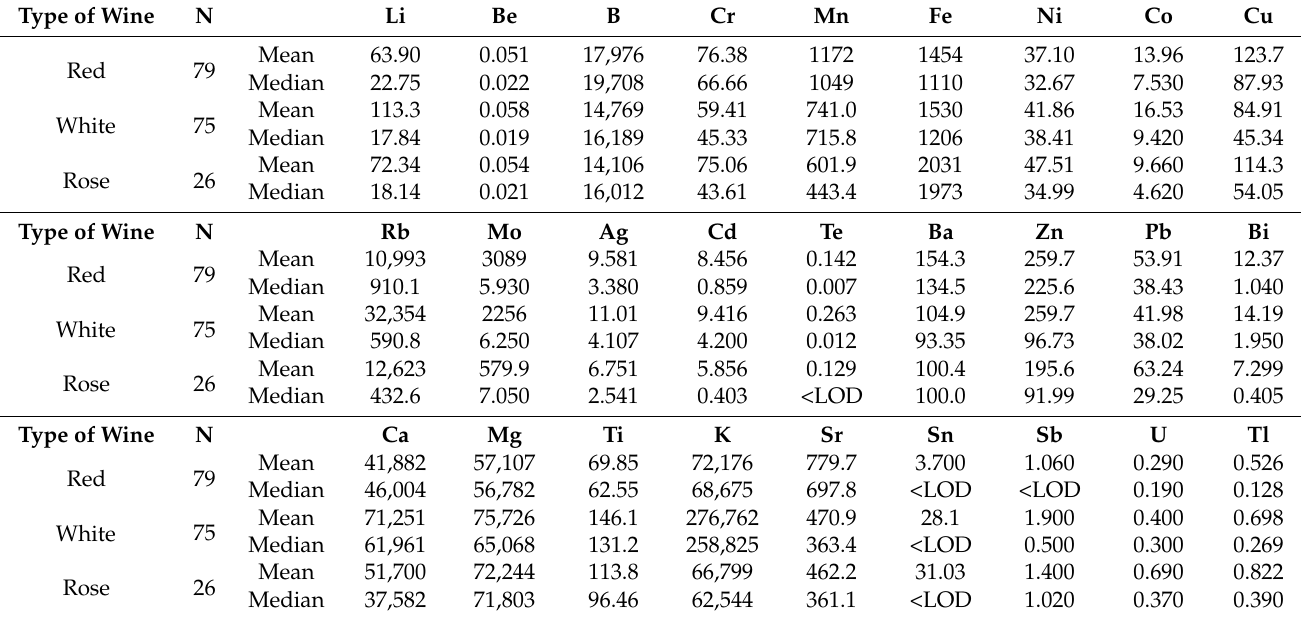
Table 7. The mean concentration and median value of each metal content in white, red, and rose wines [ µ g/L]. Type of